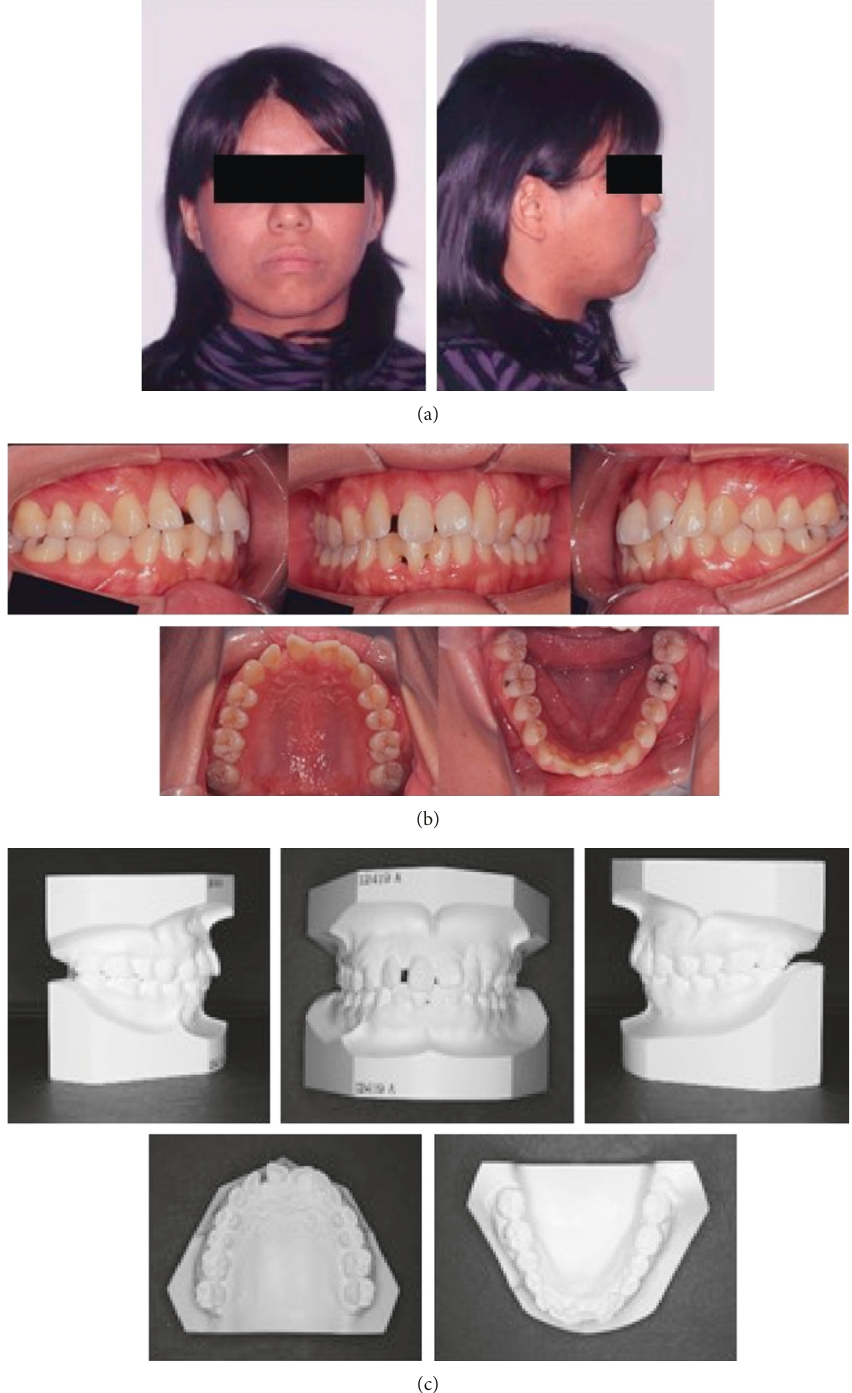
Figure 1: Pre-orthodontic treatment facial (a) and intraoral photographs (b) and dental casts (c) are